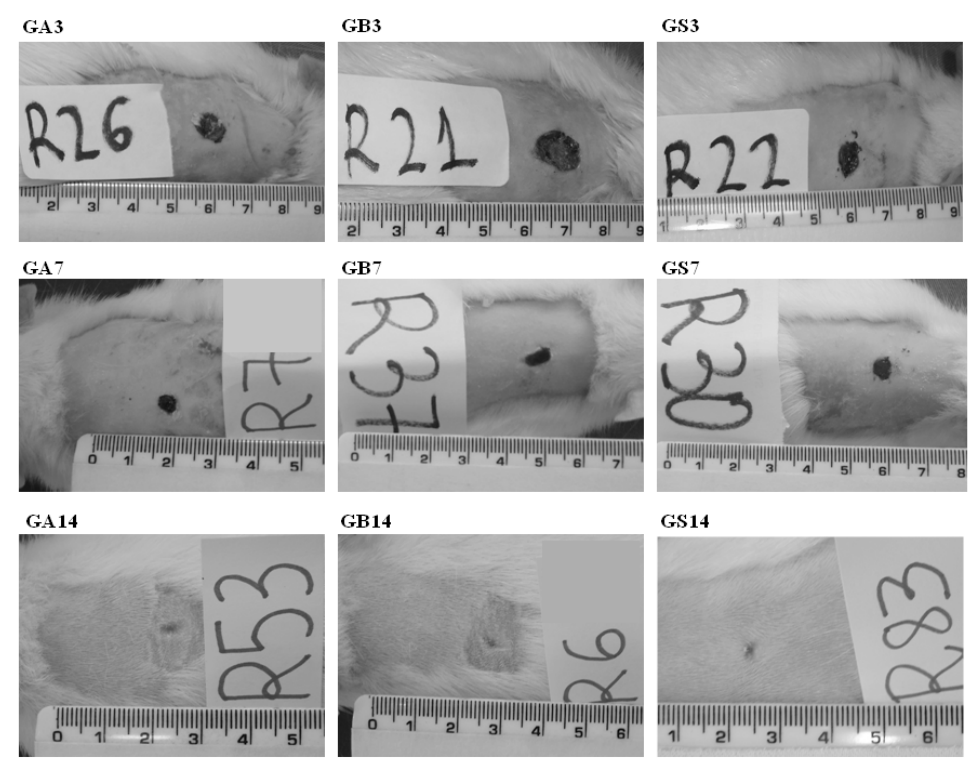
Figure 3 - Wound contraction in the HG, LG and SG at 3, 7 and 14 PO days. Note: HG- High Frequency Group. LG = Low Frequency Group. SG = Simulated Group. PO =